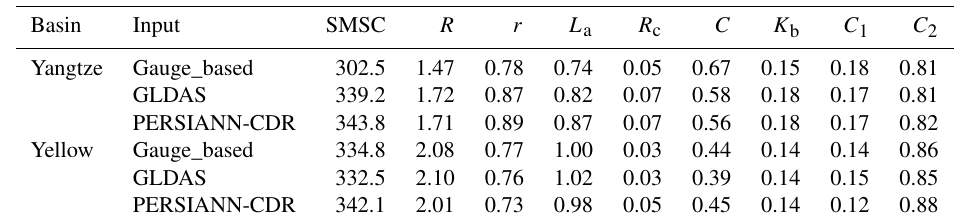
Figure 2. The monthly average runoff observed at the river outlet of the upper Yangtze River and Yellow River basin, and the precipitation data retrieved from ground-based observation, GLDAS, and PERSIANN-CDR product. Table 3. Calibrated parameter values in the HIMS model for the upper Yangtze and Yellow River basins.